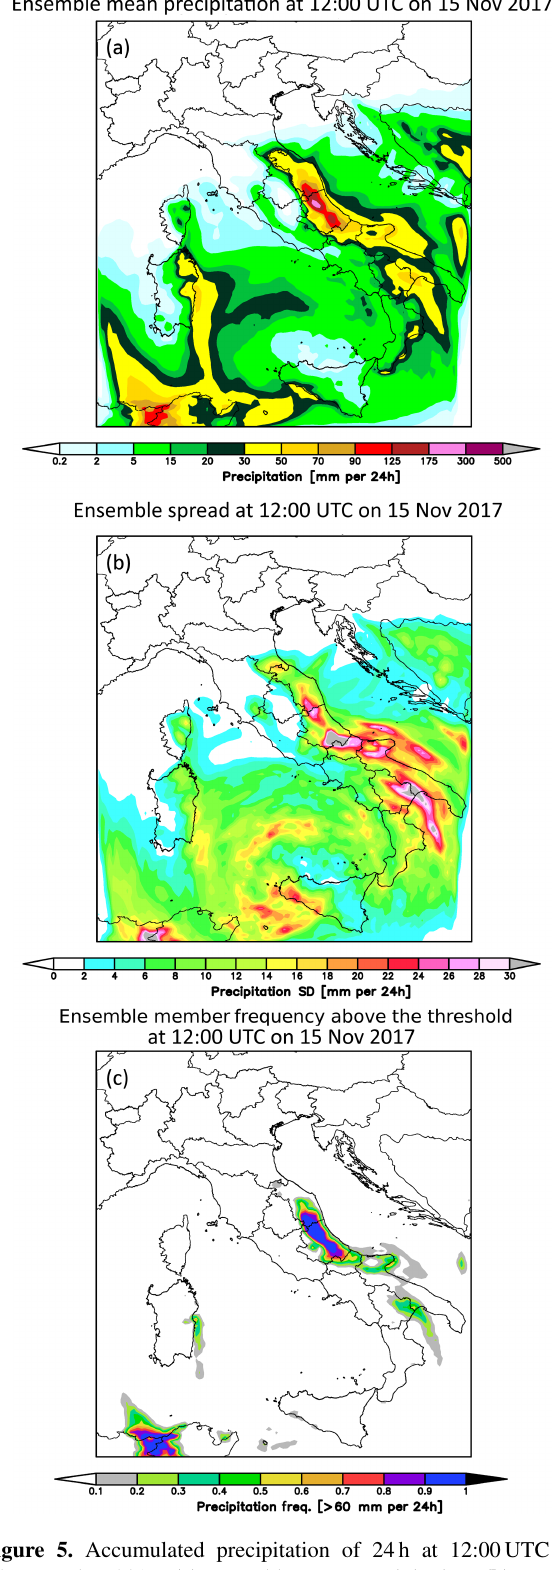
Figure 5. Accumulated precipitation of 24h at 12:00UTC on 15 November 2017: (a) ensemble mean precipitation, (b) ensem- ble spread and (c) ensemble probability of precipitation above 60mm(24h) − 1 produced by the